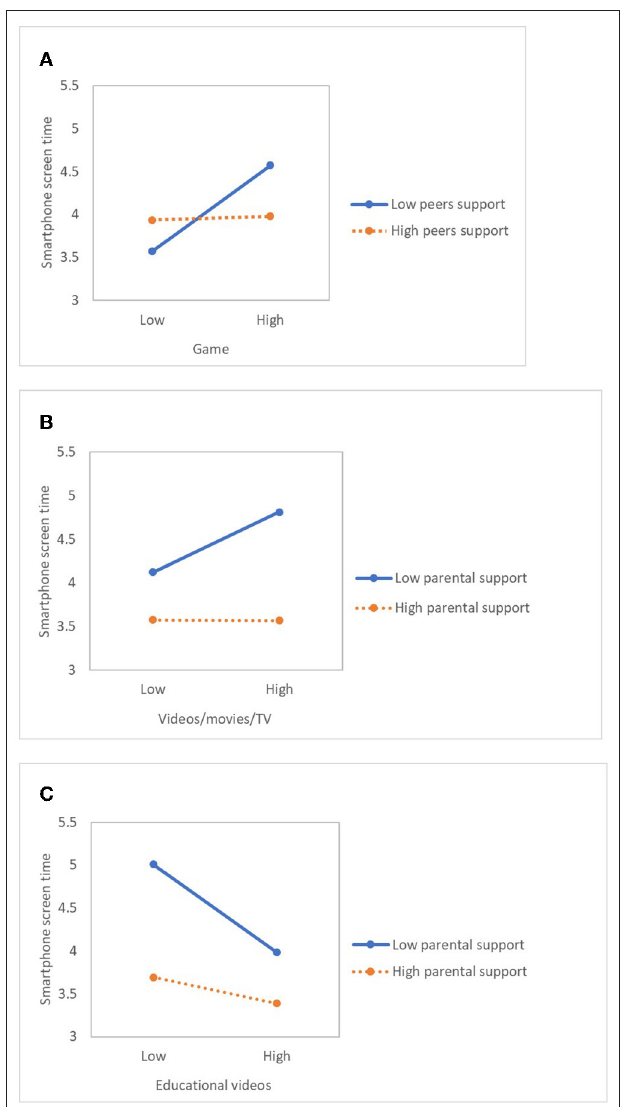
FIGURE 2 | Moderating effect of support from parents and peers. (A) Moderating effect of peer support on the relationship between game and smartphone screen time. (B) Moderating effect of parental support on the relationship between Videos/movies/TV and smartphone screen time. (C) Moderating effect of parental support on the relationship between educational videos and smartphone screen